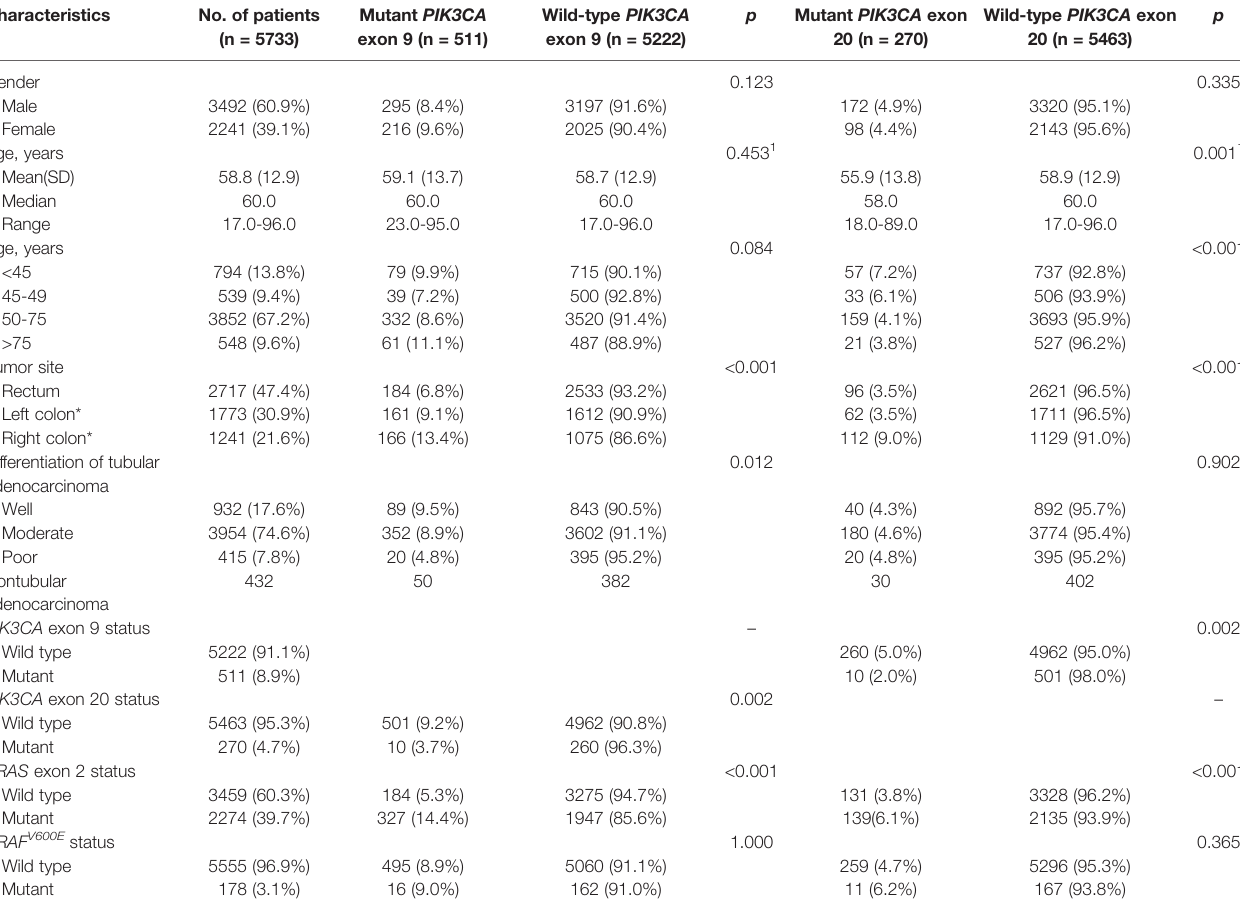
TABLE 1 | Associations of PIK3CA exon 9 and 20 mutation status with clinicopathologic characteristics.